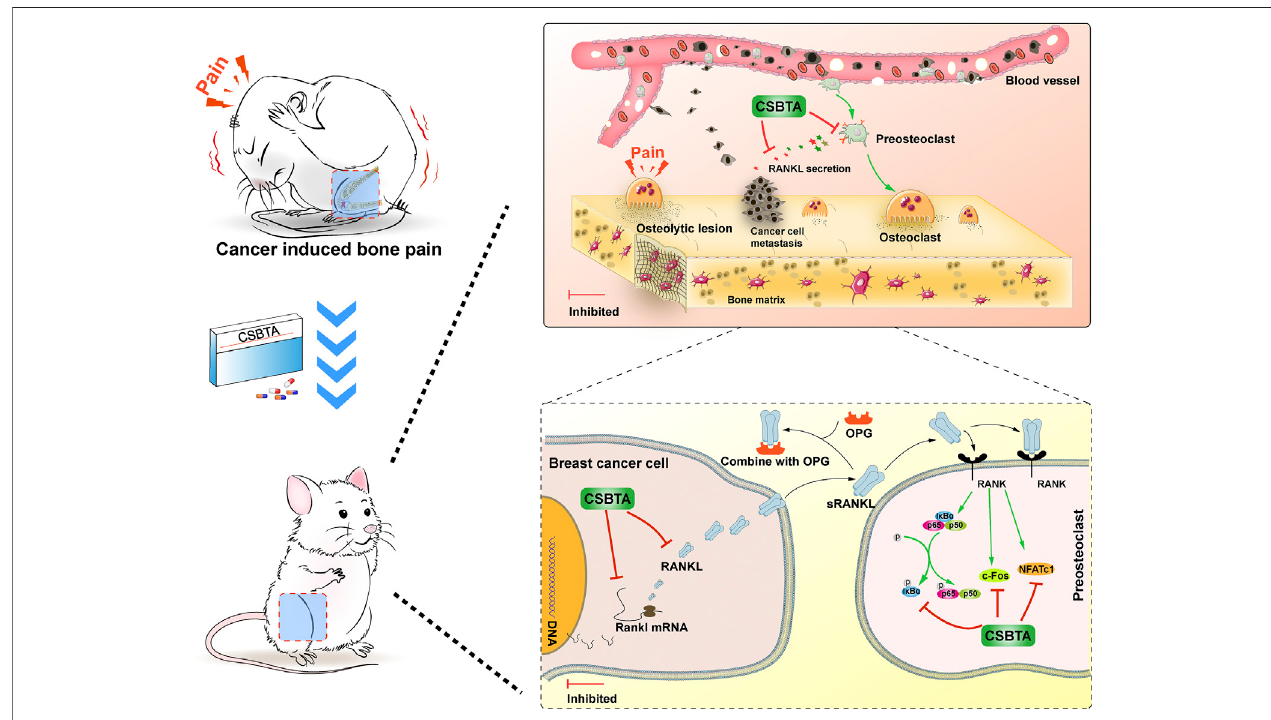
FIGURE 8 | Corydalis saxicola bunting total alkaloids attenuates Walker 256-induced bone pain, osteoclastogenesis by suppressing RANKL-induced nuclear factor- κ B and c-Fos/NFATc1 pathways in rats.